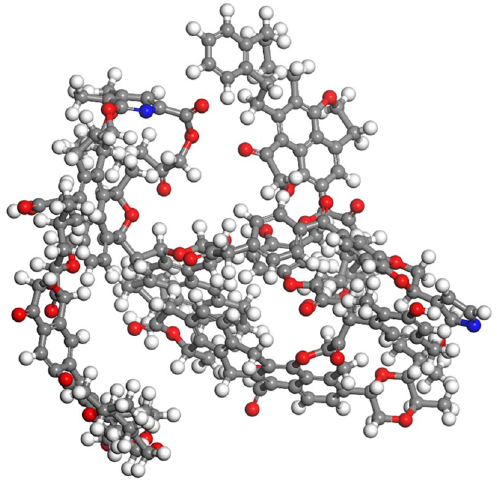
Figure 1. The basic unit of lignite molecular C 206 H 206 N 2 O 44 (C: grey; O: red; N: blue; H: